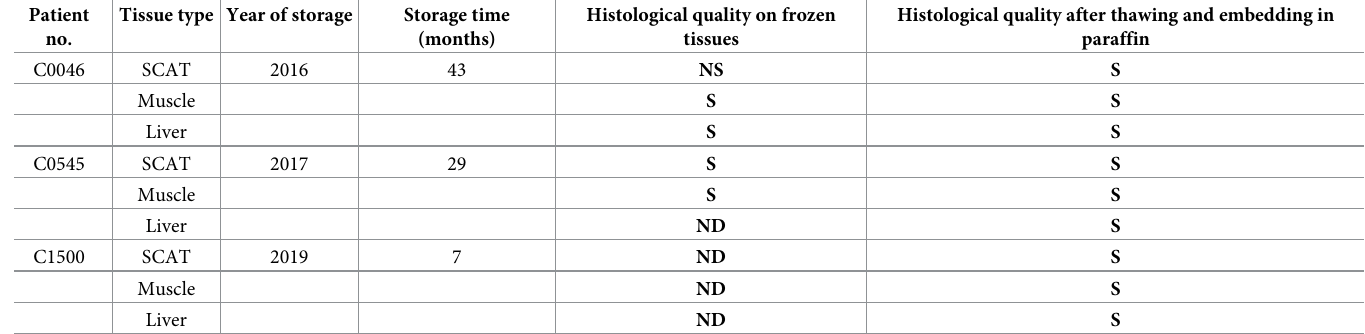
Table 8. Histological integrity according to the time of sample storage in the biobank. Tissue samples from 3 patients were analyzed for their histological integrity after several months of storage in the biobank. Sections of SCAT, liver and muscle were performed directly on frozen tissues or after thawing, fixation and embedding in paraffin, and stained with hematoxylin–eosine. Histological integrity was analyzed by the pathologist under an optical microscope. S: satisfactory quality; NS: not satisfac- tory; ND: not determined. SCAT, sub–cutaneous adipose tissue. Patient no.